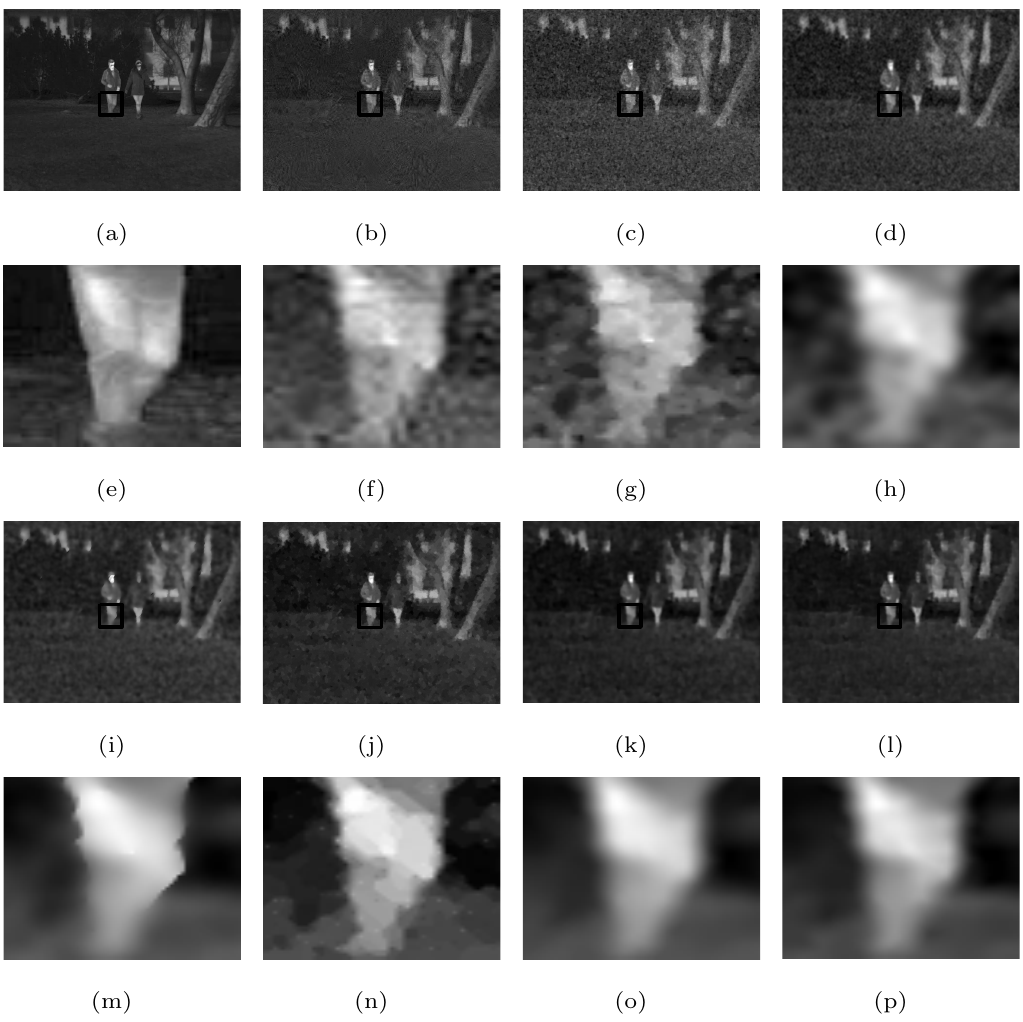
(p) 图 1: description of figure 图 1: description of figure 图 1: description of figure Figure 9. Super-resolution x2 results of the LR bird images with added white Gaussian noise ( σ = 20); 图 1: description of figure ( a – d , i – l ) ground truth and the results of the Bicubic, MFT, TV, TGV, TV4, FTV4, and FTV4Lp methods, respectively; ( e – h , m – p ) enlarged details from the rectangles in ( a – d , i – l ),